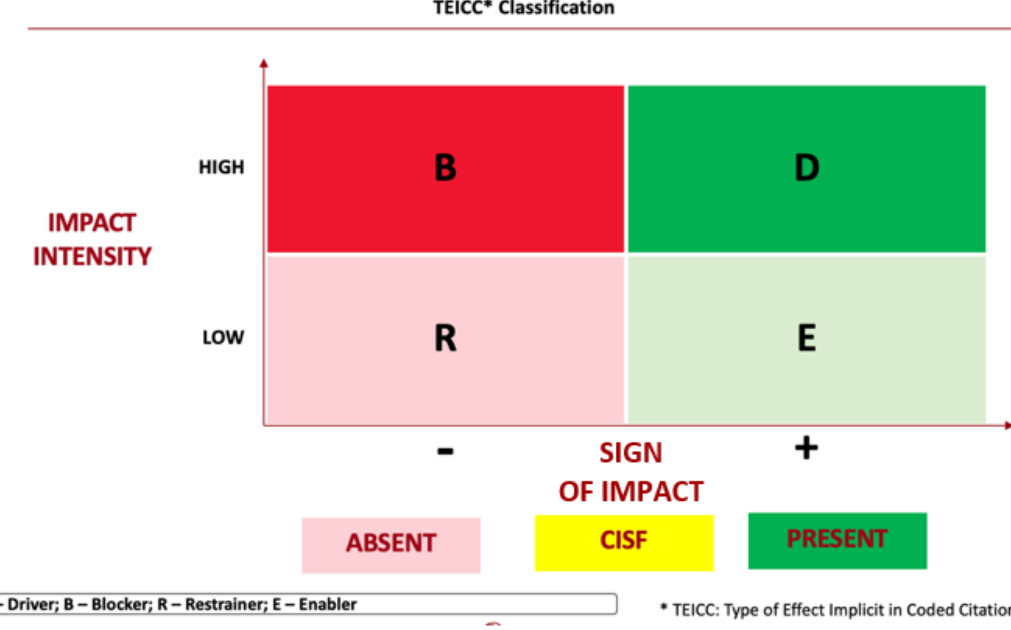
Figure 6. Classification of the Type of Effect of the CISFs. Source: the authors.